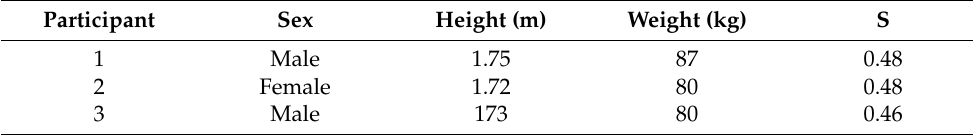
Table 2. Detailed information of all participants (S is the step length parameter).